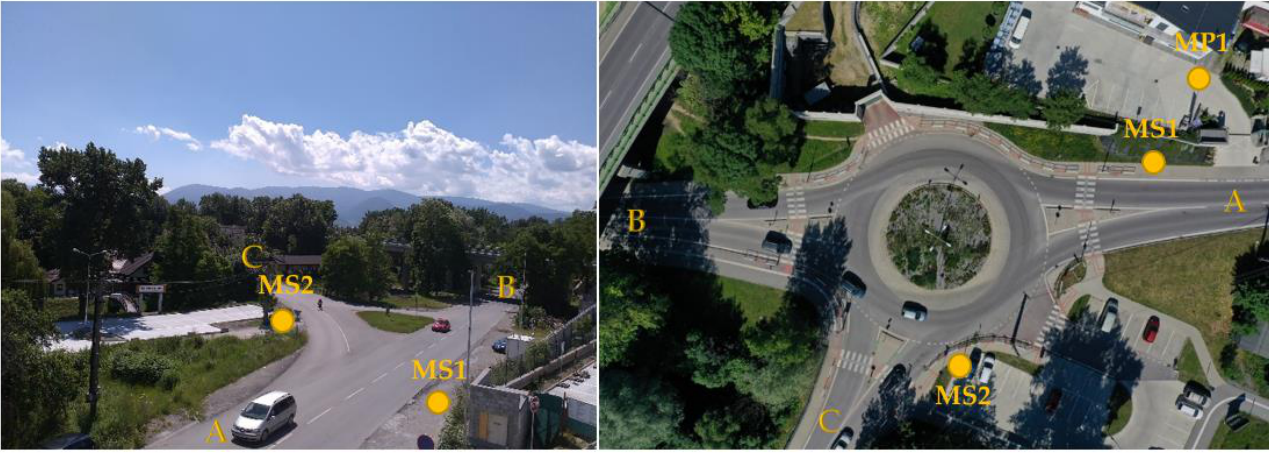
Figure 3. Photos of the three-arm intersection before ( left ) and after ( right ) reconstruction into a roundabout and marked measuring stations and intersection arms in Žilina City .